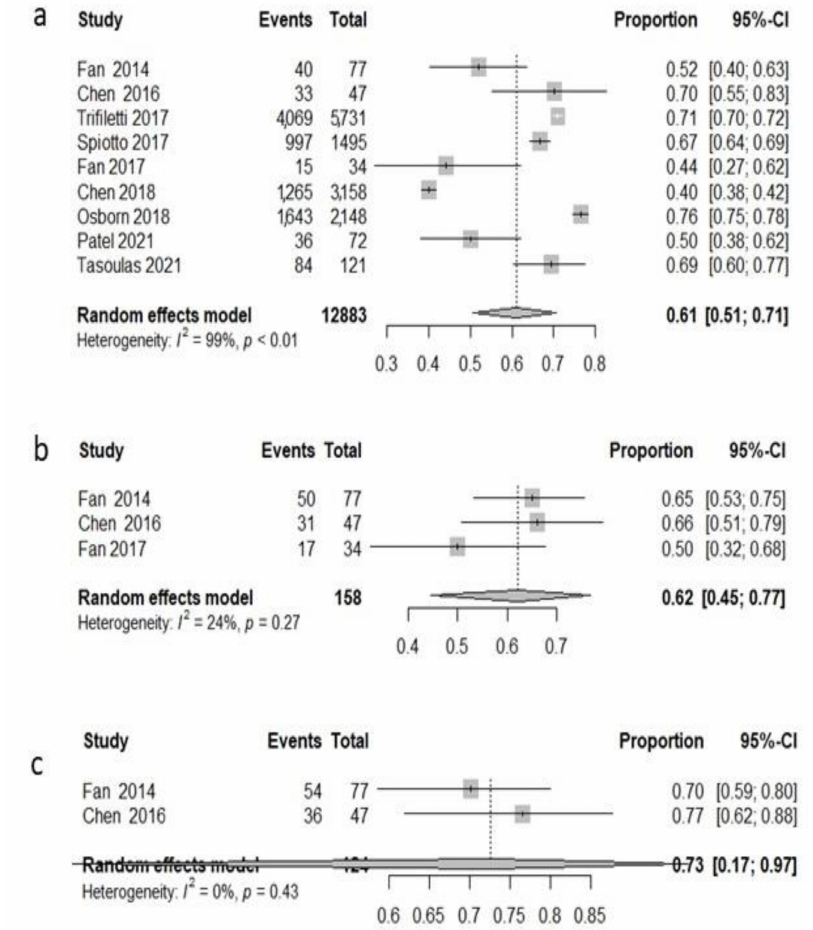
Figure 3. Forest plot, 3-year survival analysis, only RT population: overall survival (OS) ( a ); disease- free survival (DFS) ( b ); local recurrence-free survival (LRFS) ( c ). Among all patients, 10,663 were treated with radiochemotherapy across 10 studies [76–79,81–85,87], and the pooled 3 y OS rate was 72.9% (95%CI: 65.5–79.2%) with high heterogeneity (I 2 = 91.5%, p < 0.0001) (Figure 4a). Four studies [75,78,79,82] reported disease-free survival. The pooled 3-year disease-free survival was 70.9% (95%CI: 48.8–86.2%) with high heterogeneity (I 2 = 74.4%, p = 0.008) (Figure 4b). Only three studies [75,78,82] re- ported 3-year local recurrence-free survival, and the pooled LRFS was 69.8 (95%CI: 46.1–86.1%) with moderate heterogeneity (I 2 = 53.8%, p = 0.115) (Figure 4c). Globally, the results of the meta-analysis for the analyzed populations in terms of OS, DFS, and LRFS are summarized in the graph in Figure